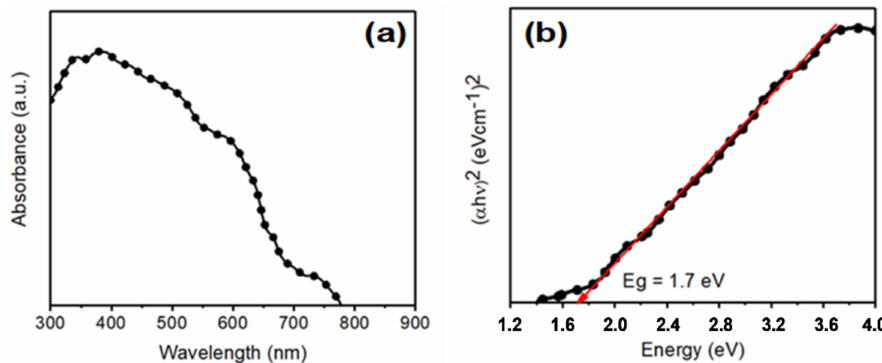
Figure 4. ( a ) UV–visible spectrum from DRS and ( b ) optical bandgap energy estimated by Tauc’s plot method for CuBi 2 O 4 NPs.